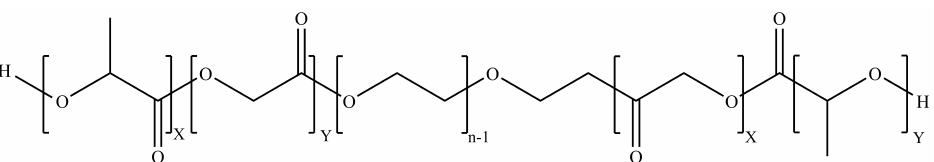
Figure 16. Chemical structure of the multiblock copolymer PLGA–PEG–PLGA (PEP). The X and Y represent the numbers of repeating subunits of lactic and glycolic acid, respectively, and the n represents the number of ethylene glycol subunits. Nanoparticles made using PEP have been shown to possess characteristics that encourage further research into their usage for brain drug- delivery